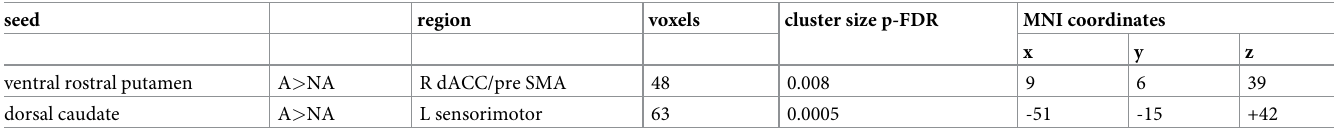
Fig 1. Changes of resting-state functional connectivity associated with apathy. (A) Seed-tovoxel analysis. The upper row shows whole brain maps of functional connectivity with seeds of the VRP and DC. The lower row shows difference of the functional connectivity between the apathy and non-apathy group for the seeds of VRP and DC. Red and blue foci indicate areas showing significant positive and negative connectivity differences, respectively. (B) Group comparison of ROI-to-ROI analysis for 12 striatal seeds. The blue lines indicate decreased connectivity in the apathy group. https://doi.org/10.1371/journal.pone.0261334.g001 To investigate the effect of apathy on the laterality of functional connectivity between the basal ganglia and cerebral cortex, we conducted a two-way ANOVA with GROUP (apathy/ non-apathy) and HEMISHPERE (the bilateral pairs of seeds), and the result did not show sig- nificant difference between the right and left striatum seeds. We performed ROI-to-ROI analysis within the striatum and compared the functional con- nectivity between two groups (Fig 1B). Compared with the non-apathy group, the apathy group showed greater reduction of functional connectivity between the right VSs and right DCP (t = -3.22, p = 0.016 for FDR). Functional connectivity between the VSi and dorsal Table 2. Regions showing significant functional connectivity differences between